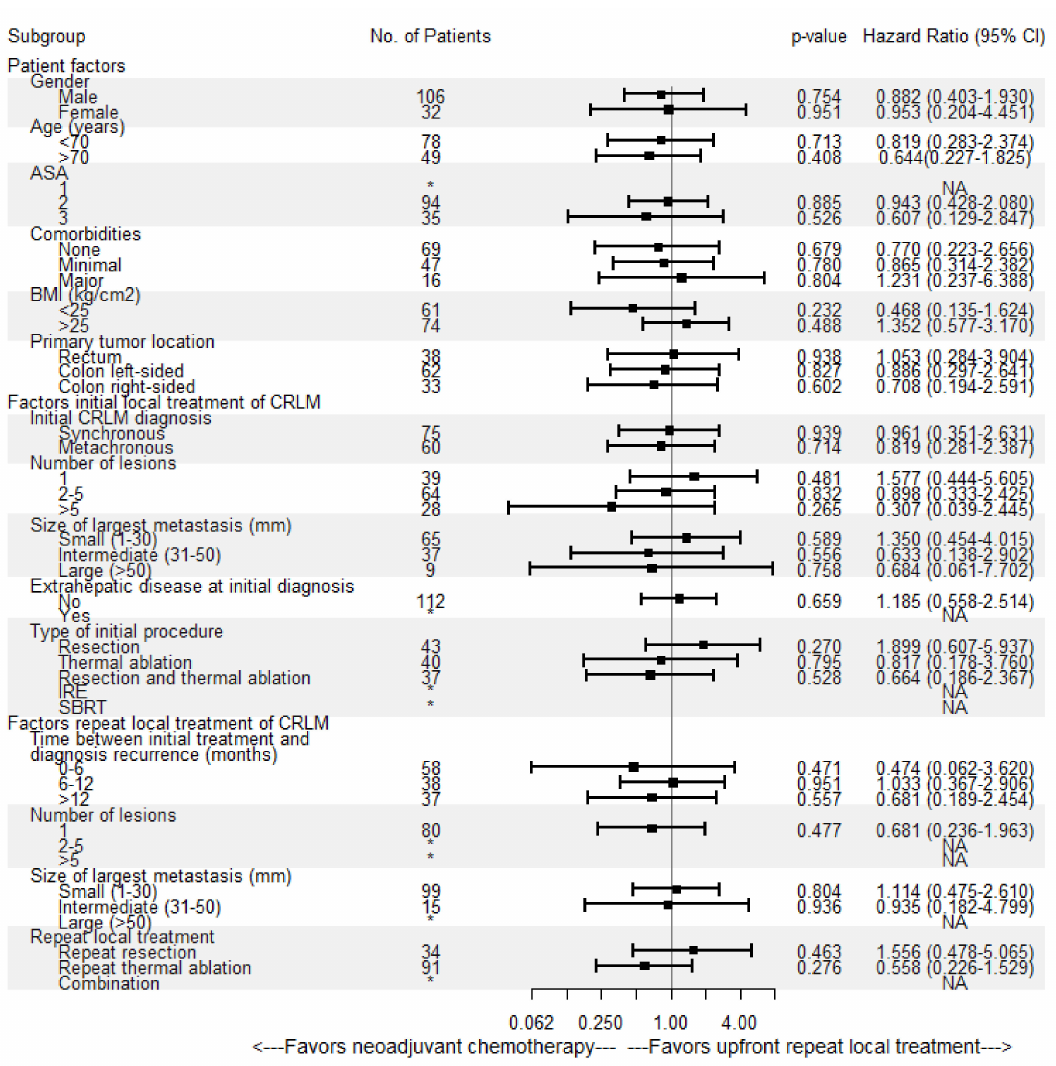
Figure 5. Univariable subgroup Cox regression analysis of upfront repeat local treatment versus neoadjuvant chemotherapy followed by repeat local treatment associated with overall survival (OS). No = number, CI = confidence interval, ASA = American Society of Anesthesiologists score, BMI = body mass index, * = insufficient subgroup size for each treatment group, NA = not